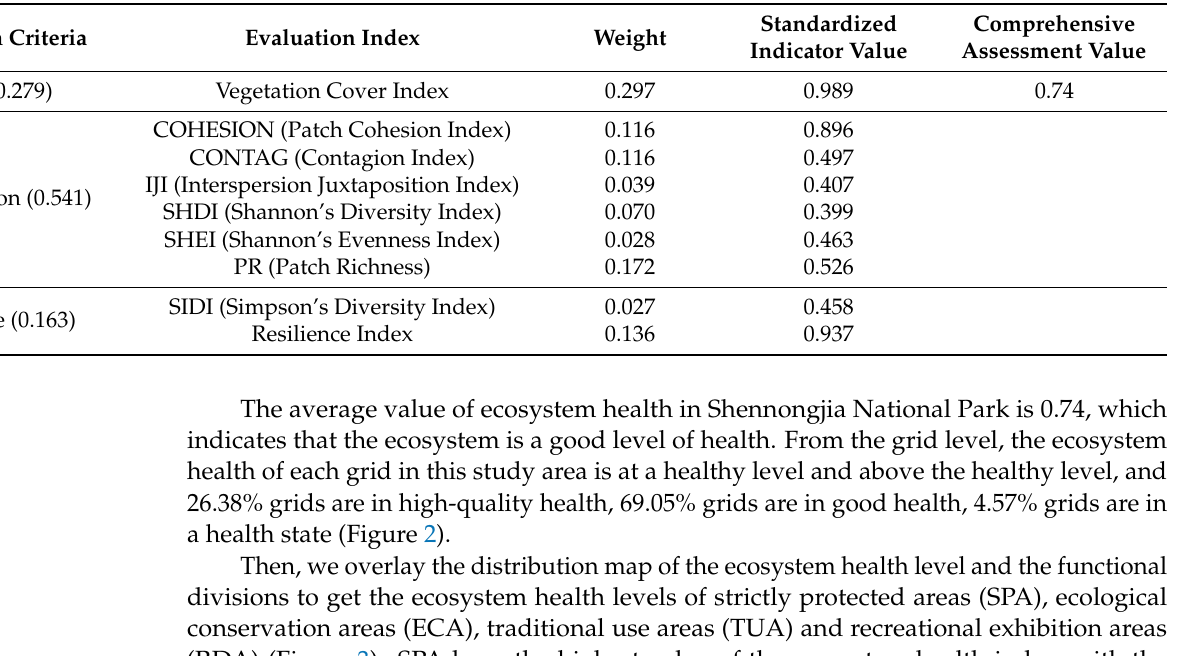
Table 7. Comprehensive evaluation of Shennongjia National Park ecological